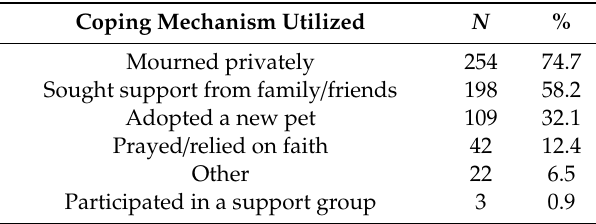
Table 2. Actions taken to find comfort after pet